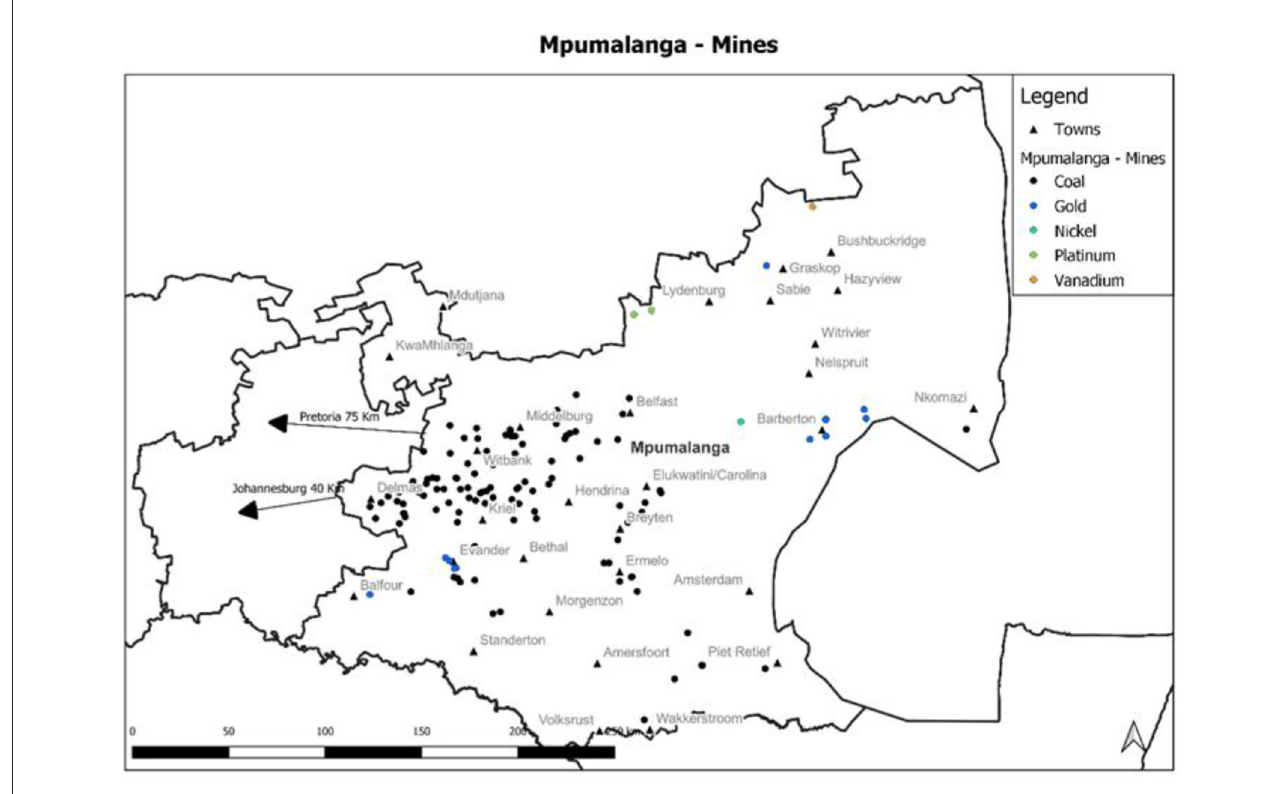
FIGURE2 Mines by type in Mpumalanga,